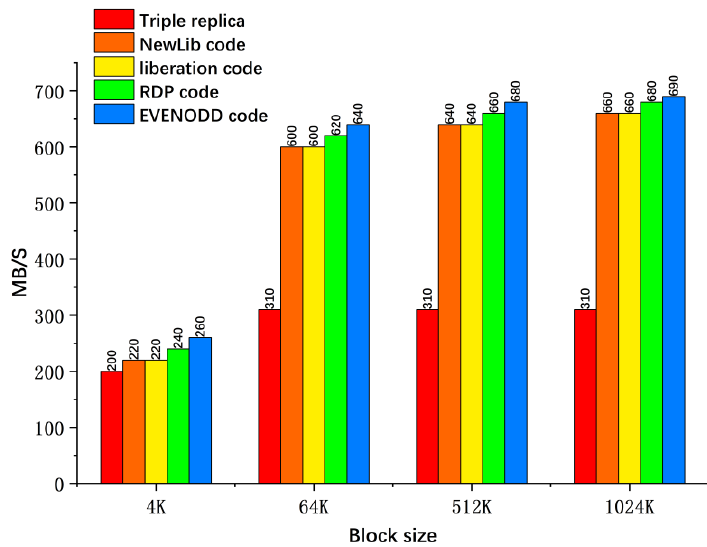
Figure 14. The throughput in the sequential